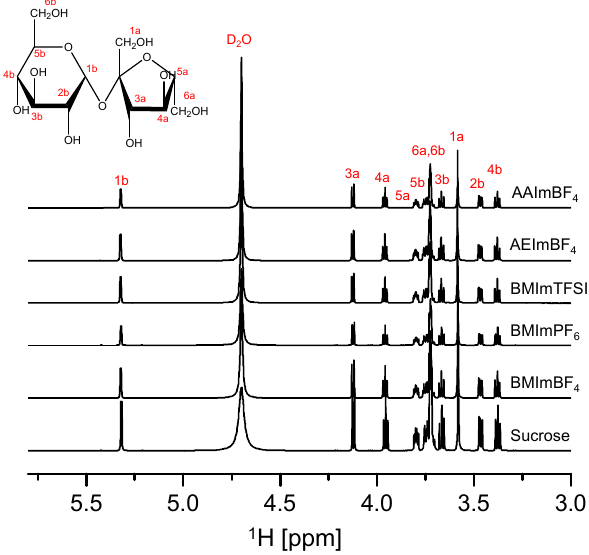
Figure 2. 1 H-NMR spectrum of sucrose crystals precipitated from the MeOH extraction solution of A. gigas when utilizing ILs as anti-solvent ( A. gigas extraction solution/ILs: 3 mL/3 mL (1:1 v / v ), solvent: D 2